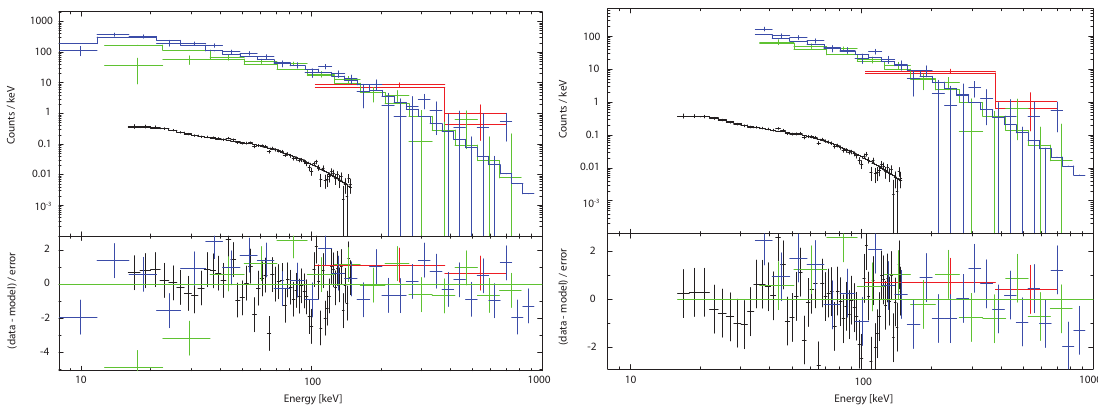
Figure 1. Joint spectral analysis of the Swift BAT (black) and the Fermi GBM NaI (green and blue) and BGO (red) for GRB 170705A (left: using the Fermi GBM NaI data from 7 keV to 1 MeV; right: using the Fermi GBM NaI data from 30 keV to 1